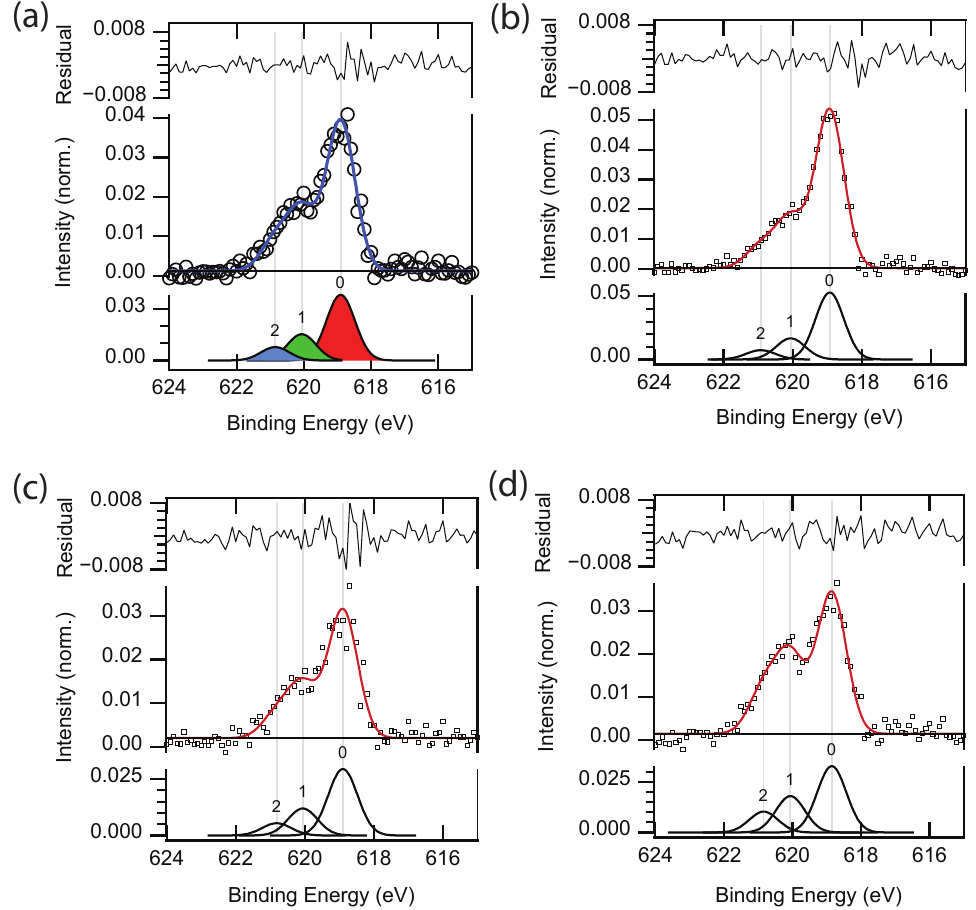
Figure 4. Fitted I 3d 5/2 difference spectra treated as described in the Methods section. Residuals and individual peak models are shown. ( a ) Average spectra calculated from samples B, C, and D. ( b – d ) Difference spectra for each sample B–D,